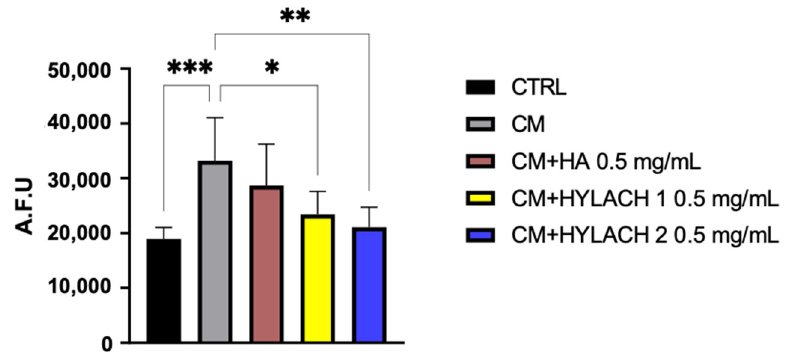
Figure 7. Reactive oxygen species (ROS) generated by primary human bronchial fibroblasts from smokers in the presence or absence of HYLACH with different degrees of lactosylation. Cells were cultured under optimal conditions and intracellular ROS generation was evaluated using CM for 12 h to induce intracellular ROS. Statistical differences are based on a one-way ANOVA test with multiple comparisons. Data are reported as mean ± SE of the percentage of fluorescence observed in at least two independent experiments. * p < 0.05, ** p < 0.01 and *** p < 0.001 compared with respective CM-treated control. Percentage of lactose-derived residues: HYLACH 1 = 10% and HYLACH 2 = 30%.